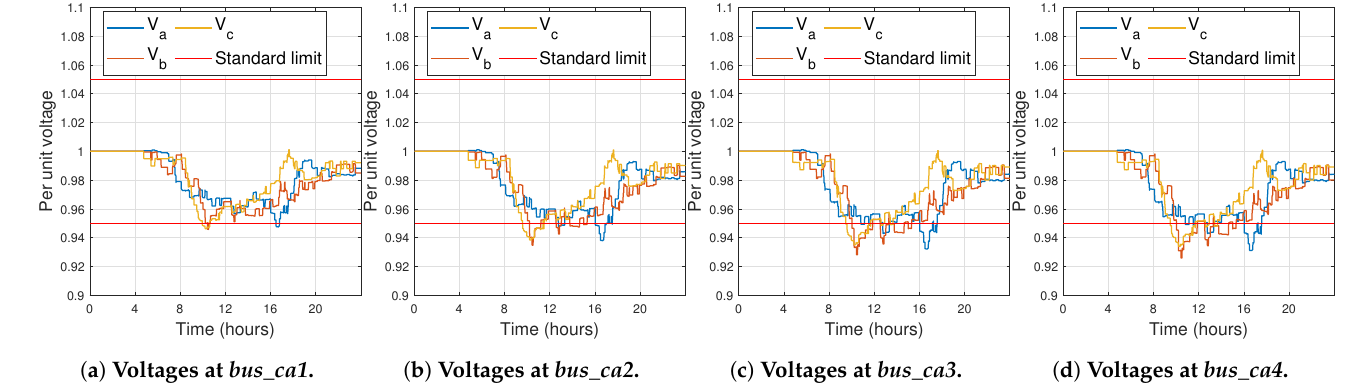
Figure 11. Voltage variation per phase during the simulated day at the main buses: ( a ) bus_ca1 , ( b ) bus_ca2 , ( c ) bus_ca3 , and ( d ) bus_ca4 (farthest main bus from the bus_STEG